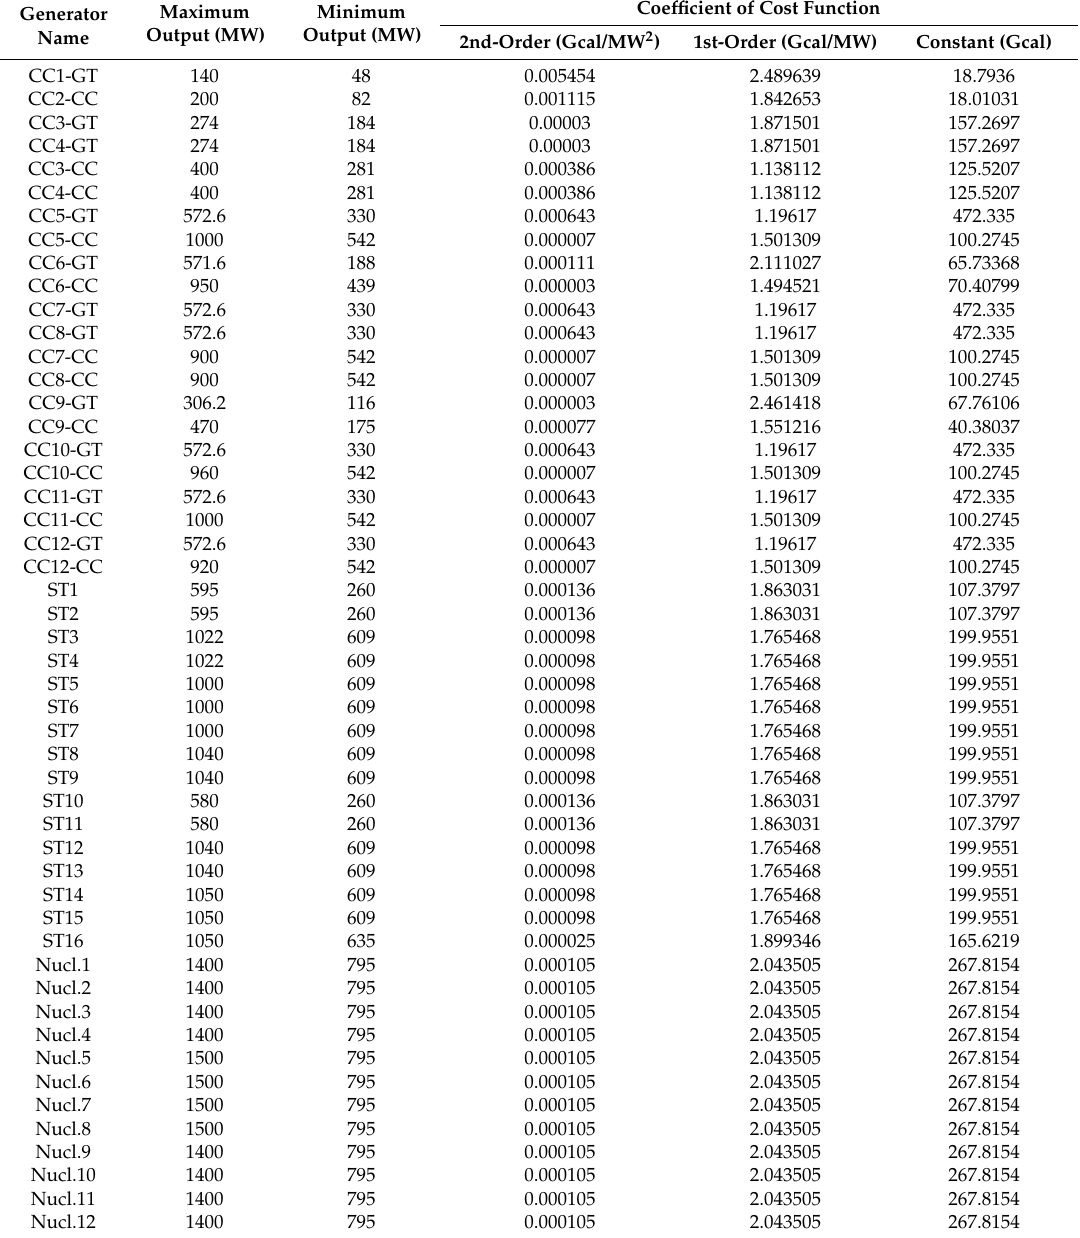
Table A1. Generation output limits and coefficient of cost function.